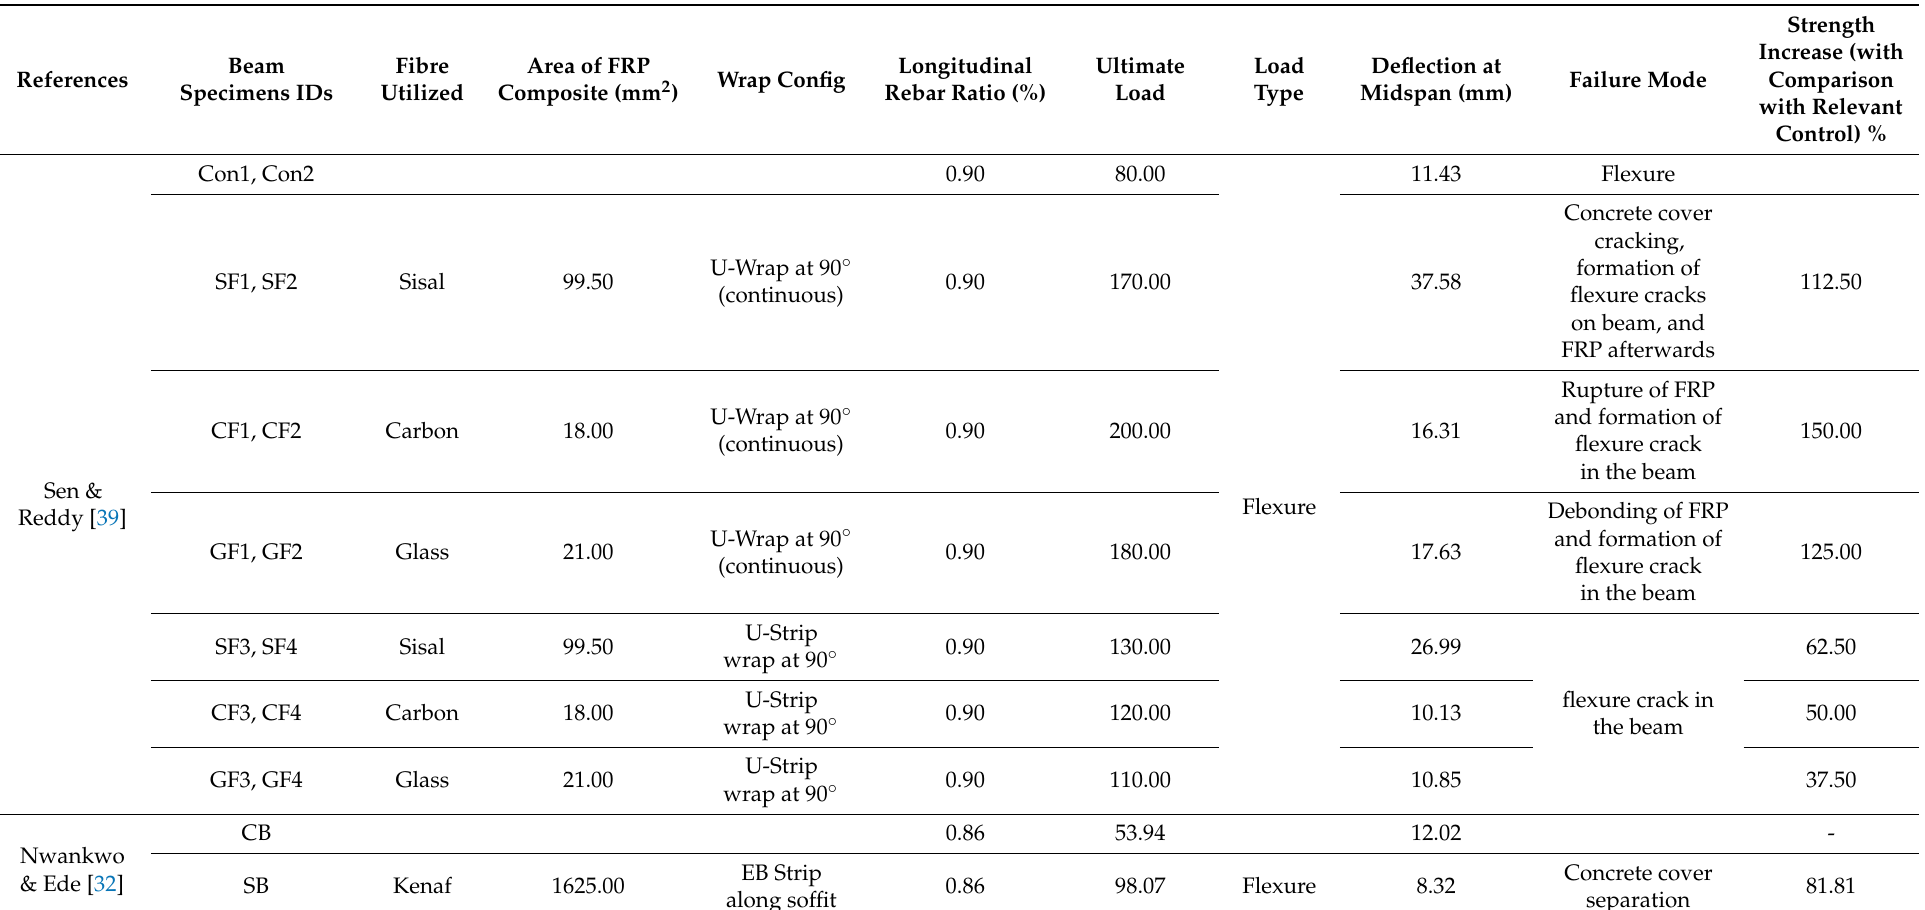
Table 3. Comparison of RC beam flexural strengthening results using EB natural